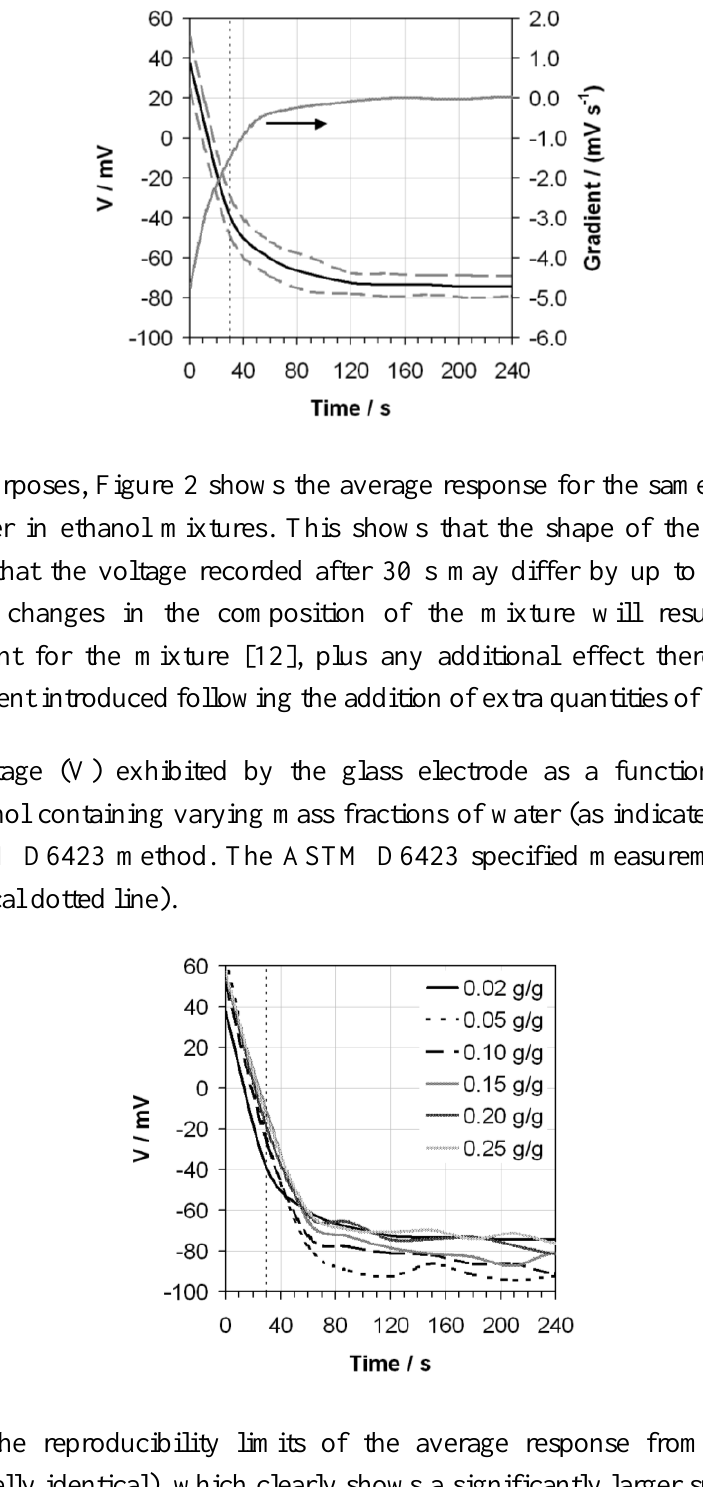
Figure 1. Average voltage (V) over ten measurements (black line) exhibited by the glass electrode as a function of time when measuring ethanol containing 0.02 g/g of water using the ASTM D6423 method. The standard deviation of this measurement set (dashed grey line) and the gradient of the average voltage response (grey line, right-hand axis) are also shown. The ASTM D6423 specified measurement time is indicated (vertical dotted line).